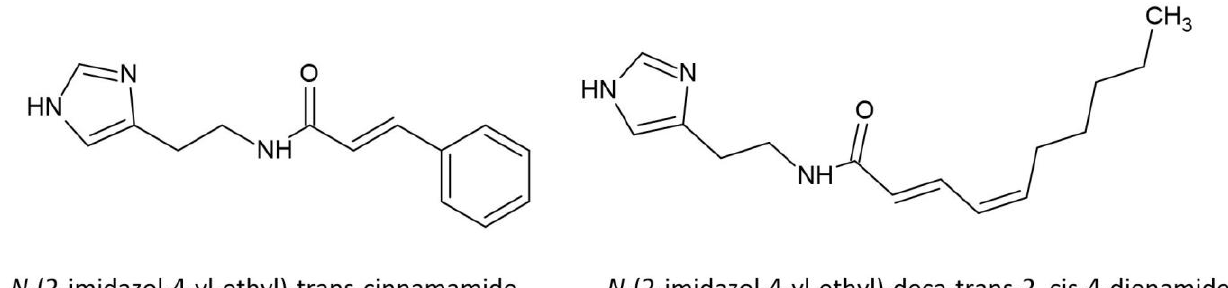
Figure 5. Structures of the two histamine amides identified in Acacia longifolia .